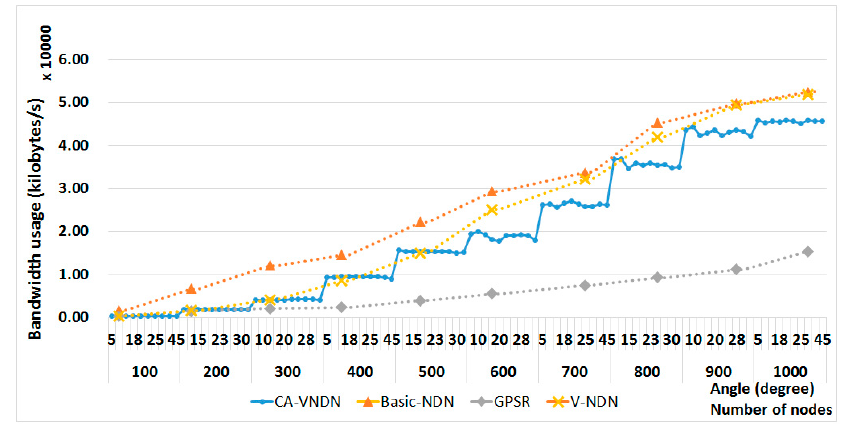
Figure 13. Bandwidth usage with the number of nodes (second line of x-axis) and suppression angle (degree, first line of x-axis).